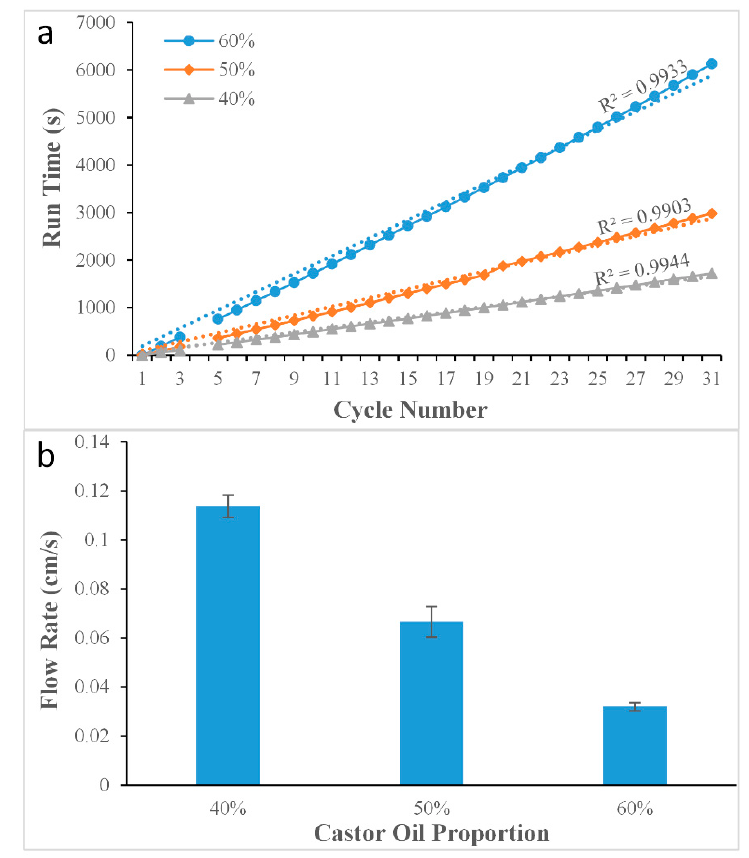
Figure 3. Results of experiment on changing viscosity of oil phase. ( a ) Flow time under different viscosity; ( b ) flow velocity under different viscosity.